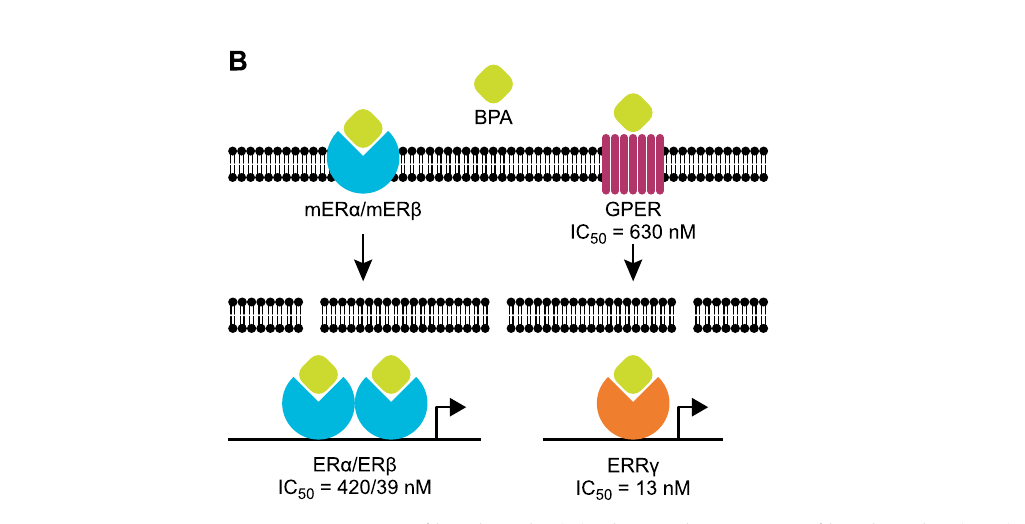
Figure 1. Toxicity of bisphenols. ( A ) Chemical structures of bisphenol A (BPA), bisphenol F (BPF), and bisphenol S (BPS). ( B ) Molecular mechanisms of BPA estrogenicity. BPA can bind nuclear and membrane-bound estrogen receptors α and β (ER α and ER β ), as well as the G protein-coupled estro- gen receptor (GPER) and estrogen-related receptor γ (ERR γ ). Half maximal inhibitory concentrations (IC 50 ) for BPA competing with 17 β -estradiol in vitro are listed below each receptor